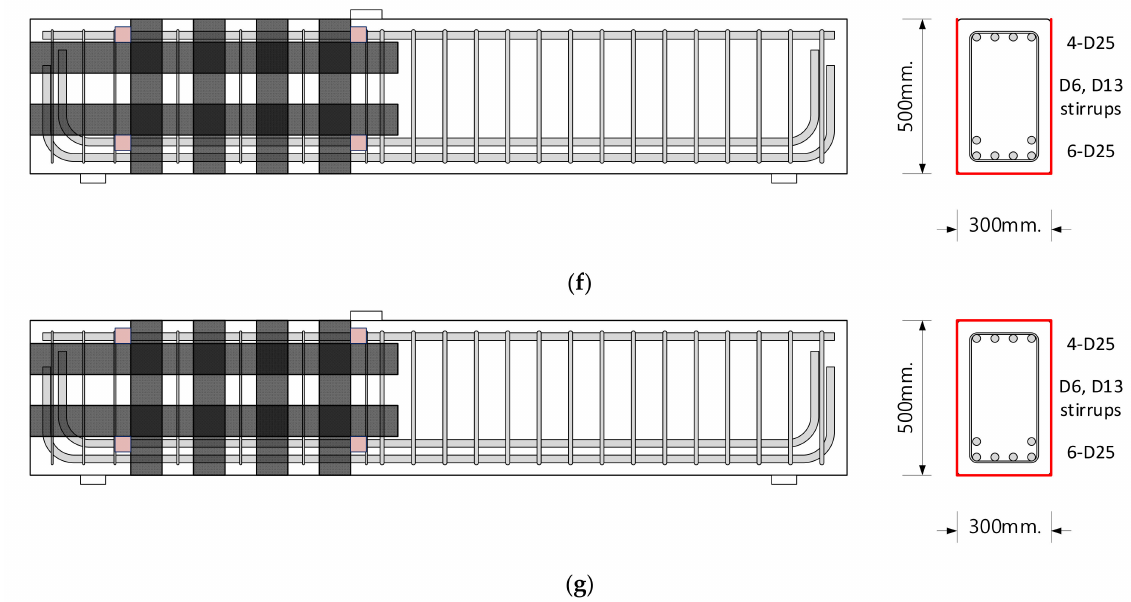
Figure 3. Main parameters of test specimens in the second series: ( a ) unidirectional side-bonded CFRP; ( b ) unidirectional U-wrapped CFRP; ( c ) unidirectional fully wrapped CFRP; ( d ) unidirectional fully wrapped with two layers of CFRP; ( e ) bidirectional side-bonded CFRP; ( f ) bidirectional U-wrapped CFRP; ( g ) bidirectional fully wrapped